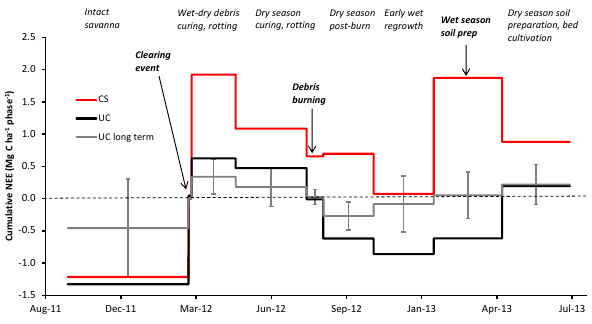
Figure 4. Cumulative NEE from the CS (red line) and UC sites (black line) for each land use phase (see Table 2 for details) over the entire observational period, September 2011 to July 2013. The UC site is a long-term savanna site of the Australian flux network (OzFlux, see Beringer et al., 2016a) and using the sites’ 8-year flux record (2007–2013), the long-term cumulative mean NEE is plotted for each land use phase of (grey line; ± 95% CI). The dashed line indicates zero net CO 2